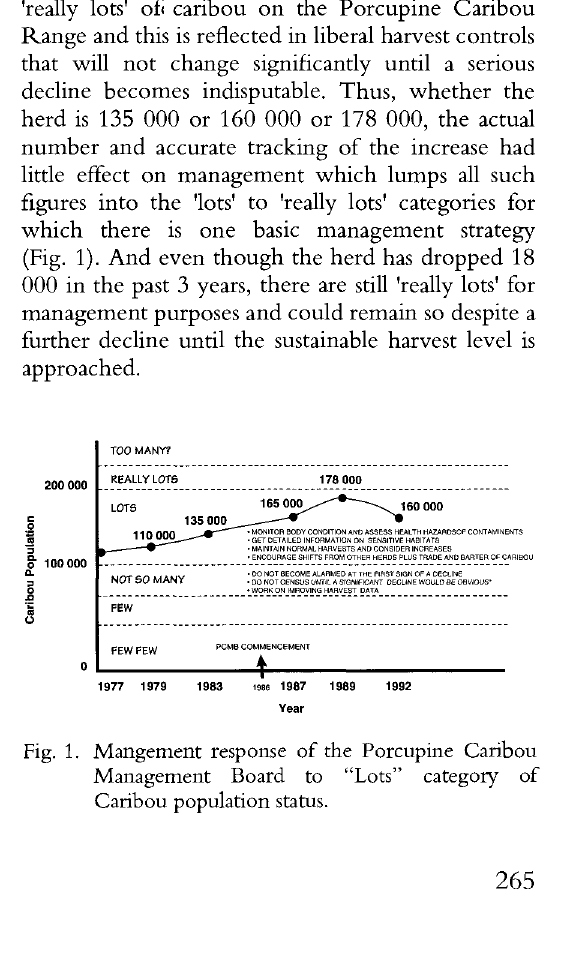
Fig. 1. Mangement response of the Porcupine Caribou Management Board to "Lots" category of Caribou population